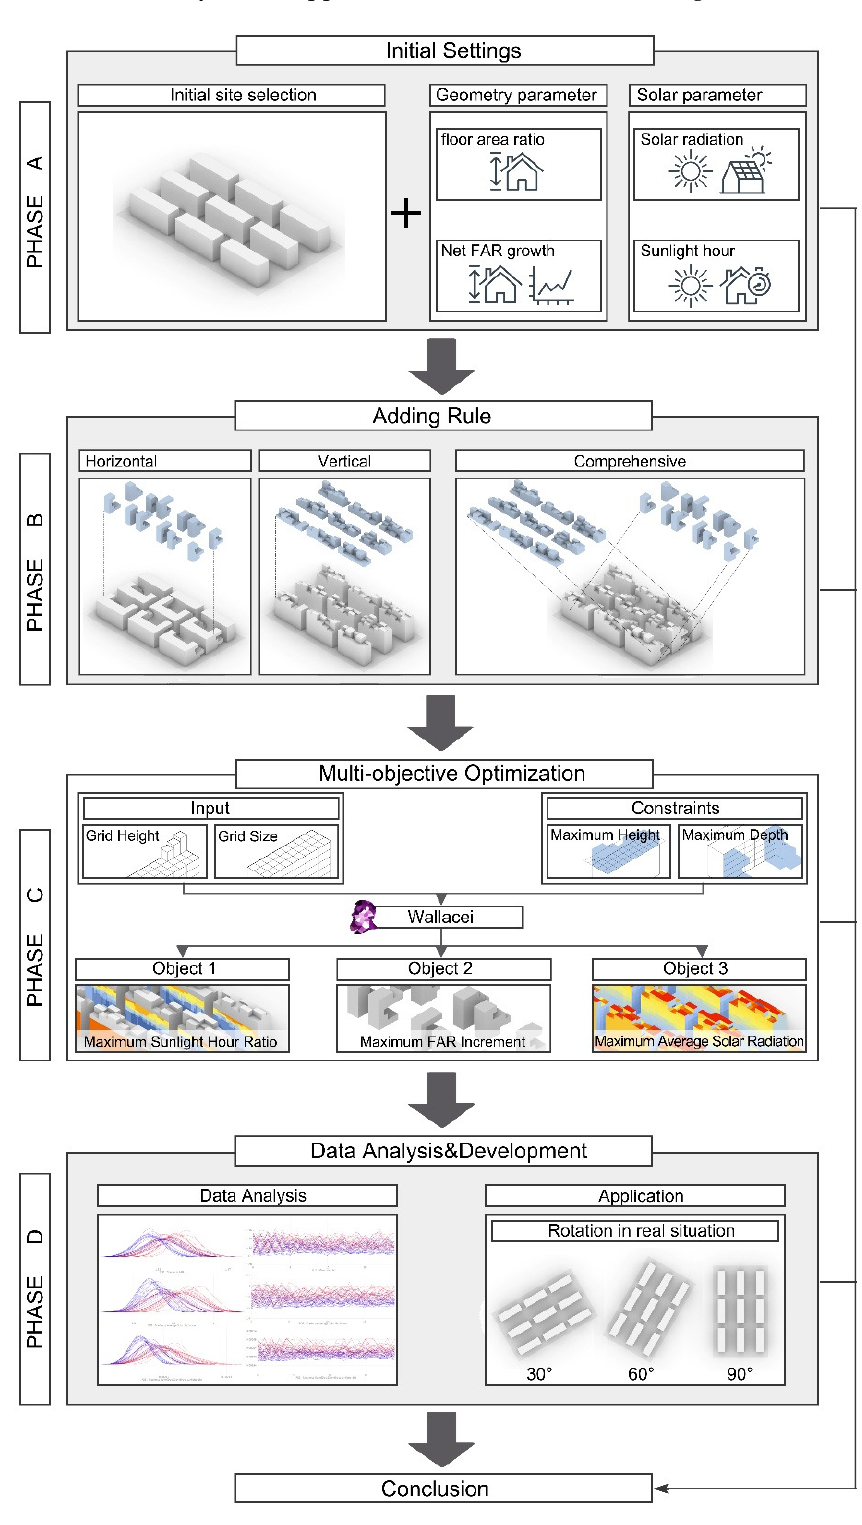
Figure 1. Framework of the research.